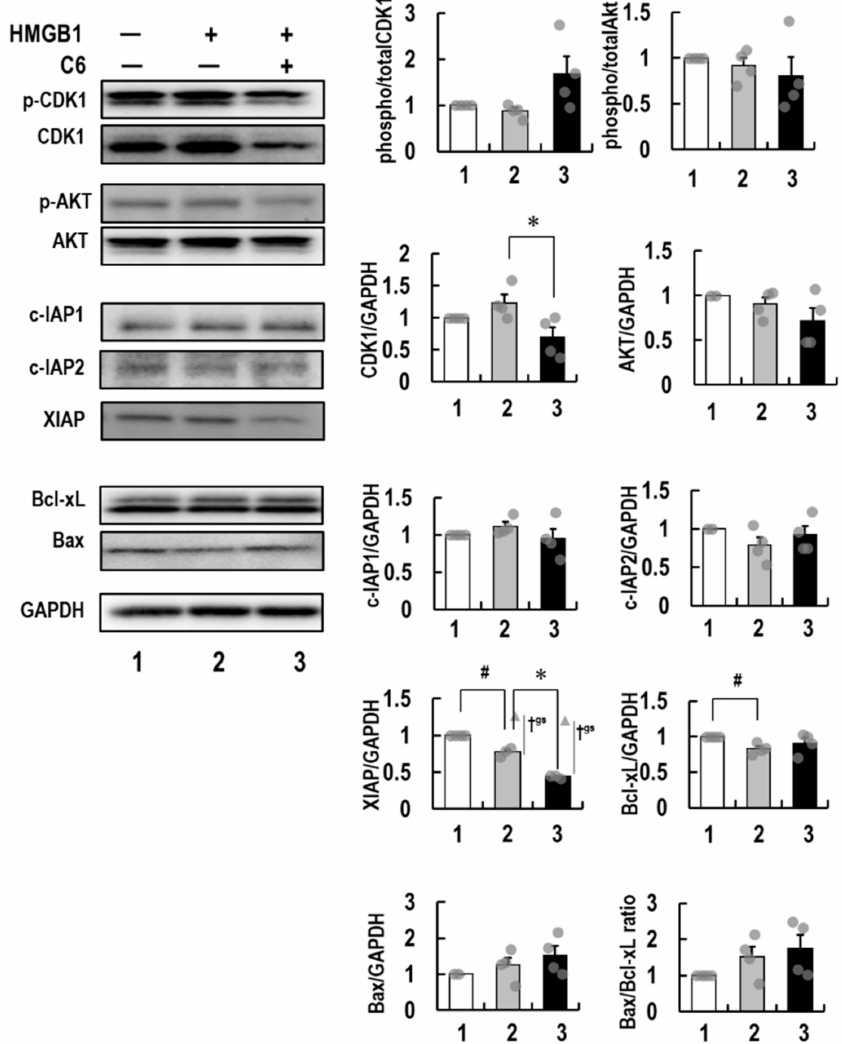
Figure 6. The effect of C6 on cell-cycle-, proliferation-, and apoptosis-related proteins in HMGB1- stimulated HCT116 cells. ( left blotting panels ) Immunoblot analyses of phospho-CDK1 and -AKT and the protein levels of IAPs, Bcl-xL, Bax, and GAPDH were performed using protein lysates from HCT116 cells pre-treated with 3 µ M C6 for 2 h with 10 µ g/mL HMGB1 or vehicle for 72 h, as described in Section 4. GAPDH served as a loading control. ( right ) The relative ratios were presented as the bar of at least three independent experiments of each protein band intensity determined by densitometric analysis. The significance was tested by the Student’s t -test (# or * p < 0.05). Smirnov– Grubbs test was used to remove outlier data. The significance level was set as α = 0.05. The outlier data were expressed as a triangle plot and specified as † gs . The original image of Figure 6 is shown in Supplementary Figure